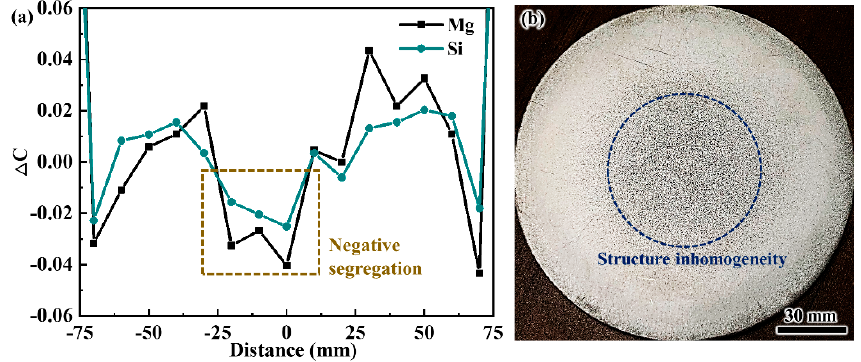
Figure 3. ( a ) Macrosegregation profiles of solute Mg and Si, ( b ) macrograph of the billet cross-section.